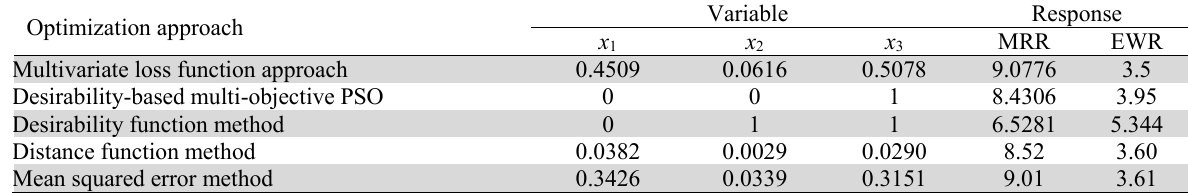
Variable Response x 1 x 2 x 3 MRR EWR